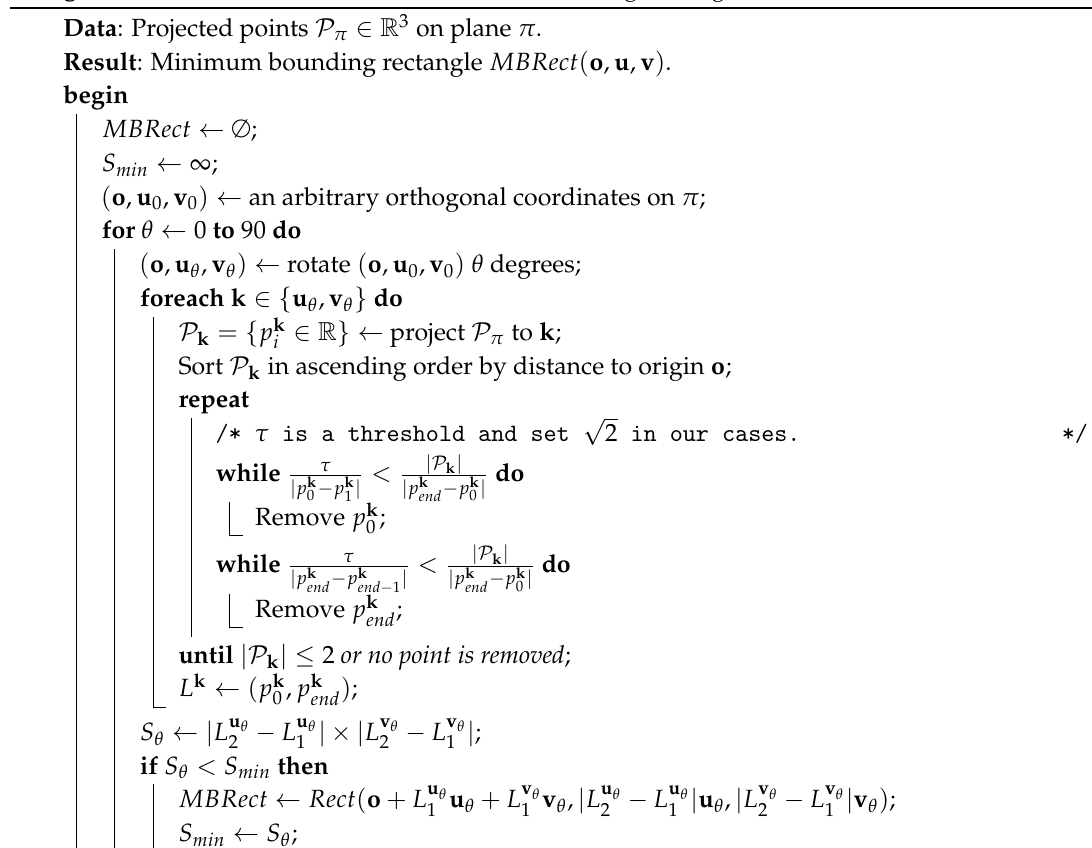
Algorithm 1: Robust extraction of minimum bounding